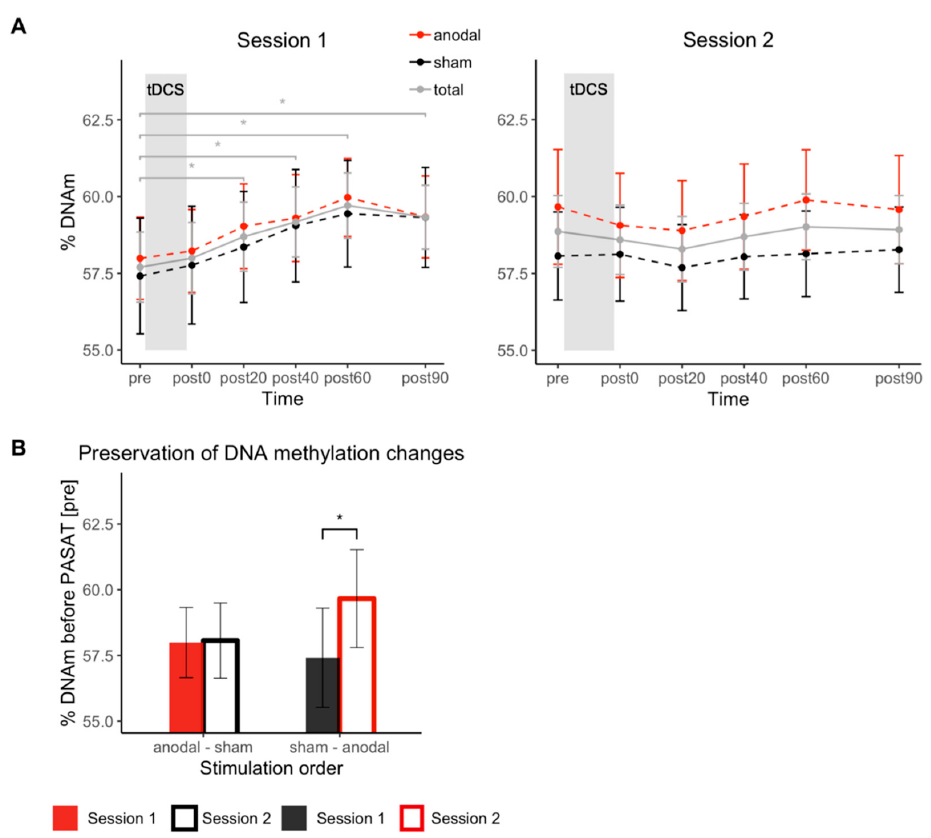
Figure 3. DNAm changes during each session with regard to stimulation condition and its preser- vation over one week. ( A ) % DNAm is shown separately for the six time points during each session. Each participant in the anodal stimulation group in session 1 ( n = 21) was receiving sham stimulation in session 2, and vice versa ( n = 21). ( B ) % DNAm for session 1 and 2 at time point ‘pre’ grouped by order of stimulation conditions (‘anodal/sham’ ( n = 21) or ‘sham/anodal’ ( n = 21)). The figure illus- trates the comparison of % DNAm before (‘pre’) the first (session 1) and second (session 2) PASAT training within subjects who received tDCS (‘anodal/sham’) and subjects who did not receive effec- tive tDCS in session 1 (‘sham/anodal’). Error bars depict standard errors of the mean; asterisks mark p < 0.05.